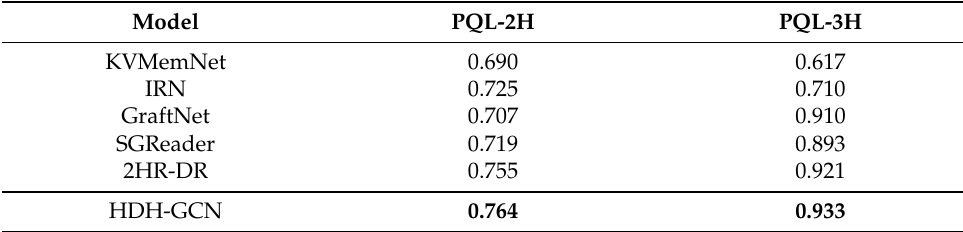
Table 3. Results of Hit@1 on PQL-2H and PQL-3H.